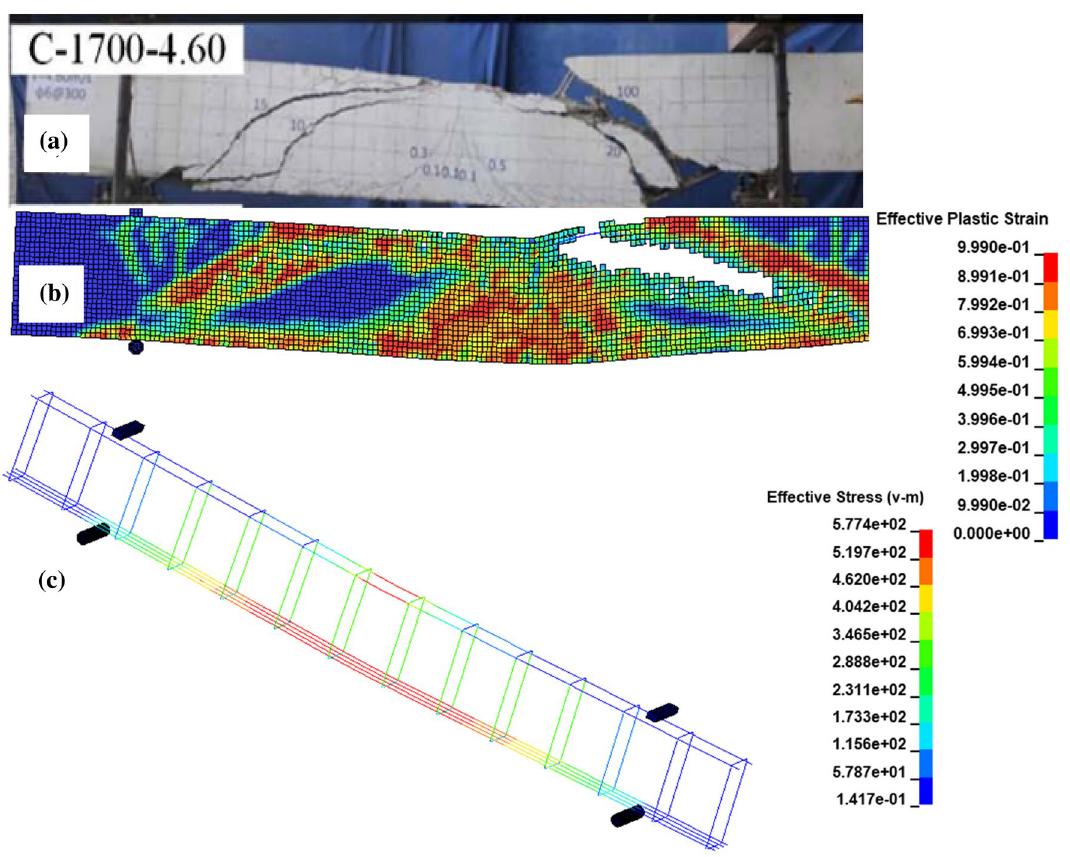
Fig. 8 The overall failure of the C-1700-4.6 specimen, a experiment, b FEM, c Reinforcement effective stress (Von-Mises)